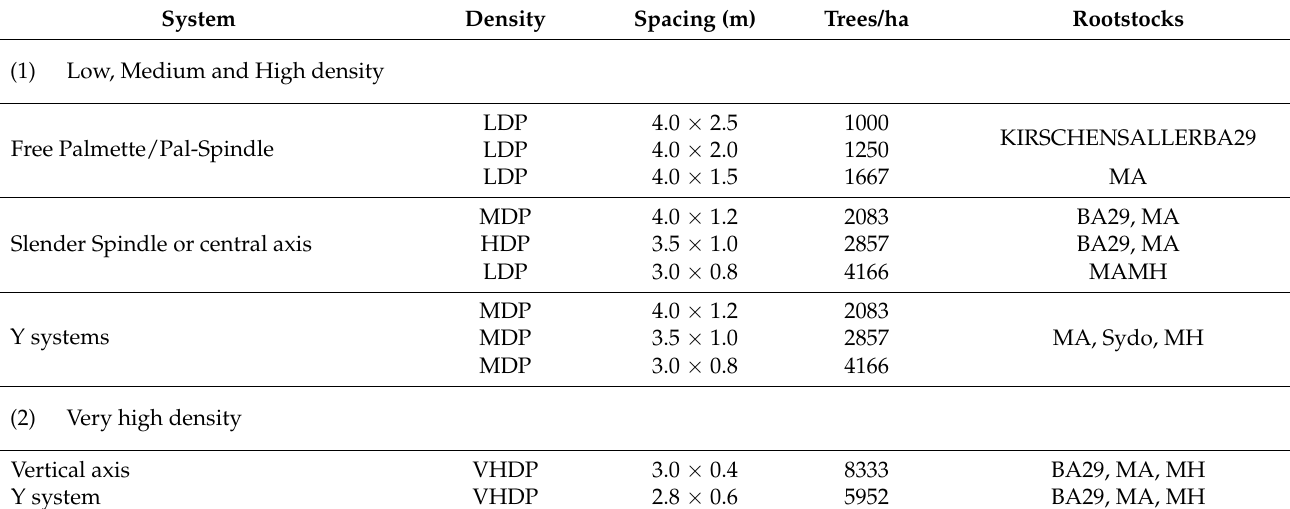
Table 3. Training Systems and spacing of pear orchards in Spain’s main district Ebro Valley (2010–2020). System Density Spacing (m)